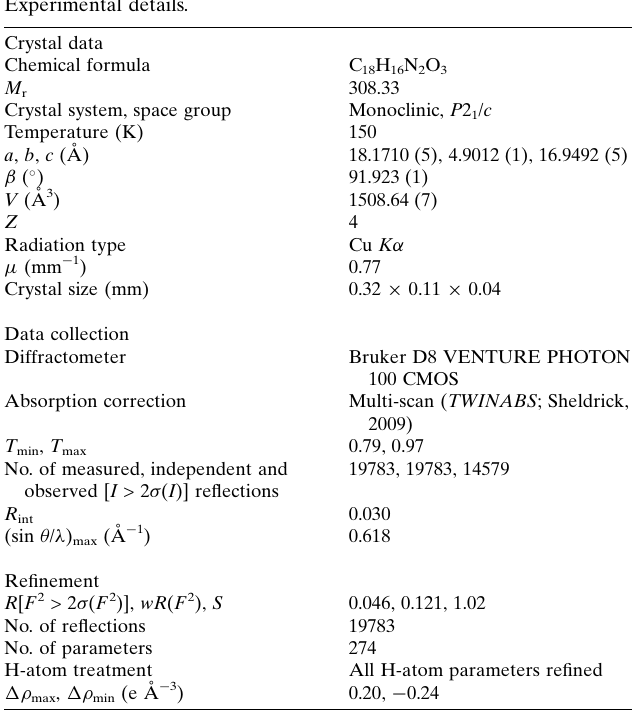
Table 2 Experimental details.